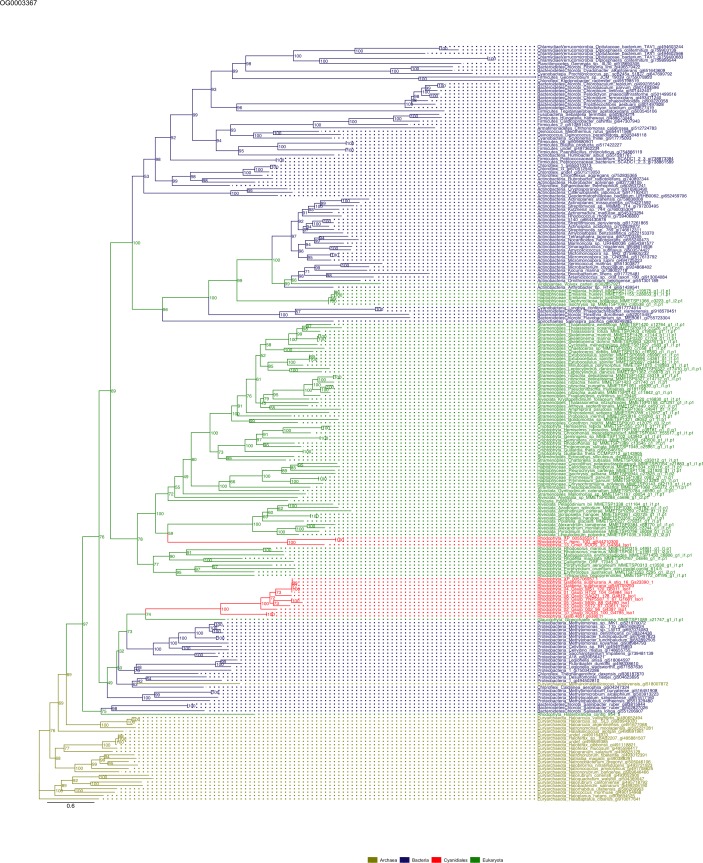
Sequence tree of orthogroup OG0003367.The tree is based on amino acid sequences. Archaea (yellow), Bacteria (blue), Cyanidiales (red), Eukaryotes including other red algae (green). Branches containing Cyanidiales sequences are highlited in red.